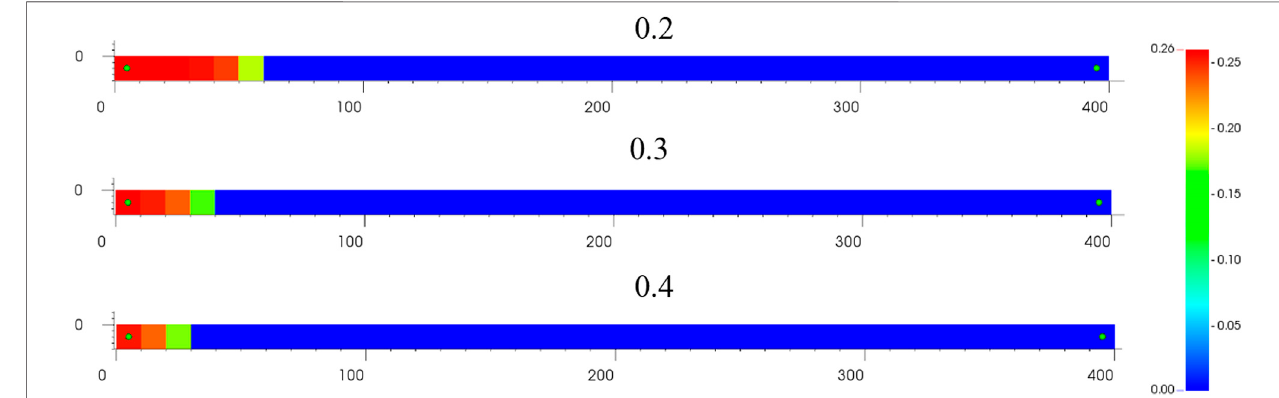
FIGURE 8 | Gas saturation.